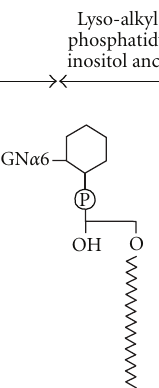
Figure 1: Structure of Lipophosphoglycan from Leishmania donovani . The four key domains (cap, phosphoglycan repeating units, glycan core and lipid anchor) are discussed further in the text. The number of phosphoglycan (PG) repeating units increases during metacyclogenesis, contributing to the role of LPG in complement resistance. In many Leishmania species, side chain modifications of the PG Gal residue are common, where they can play a role in sand fly transmission. The structure of the cap also di ff ers amongst species. Gal, galactose; Man; Mannose; GN, glucosamine; Glc, glucose.